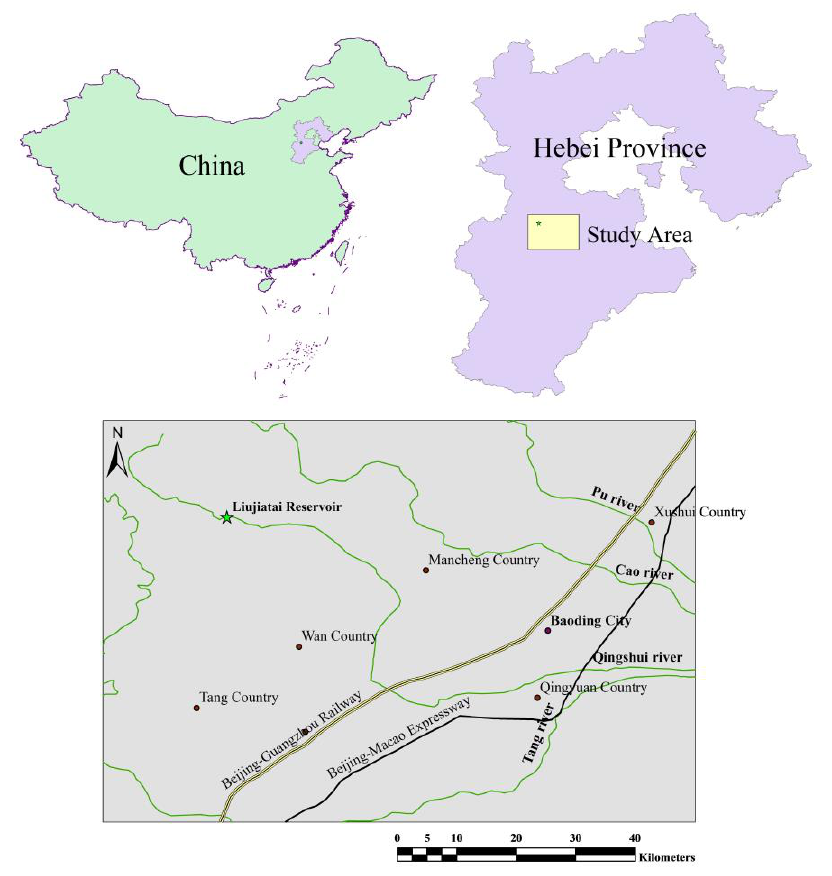
Figure 5. Location of the Liujiatai Reservoir.